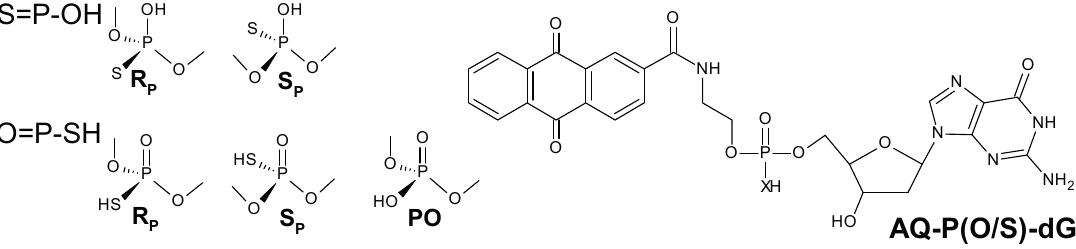
Figure 1. Graphical representation of AQ-PO-dG, AQ-PS-dG and phosphorothioate internucleotide bond stereochemistry and antraquinone (AQ) covalent linkage to 5 ′ -end of the